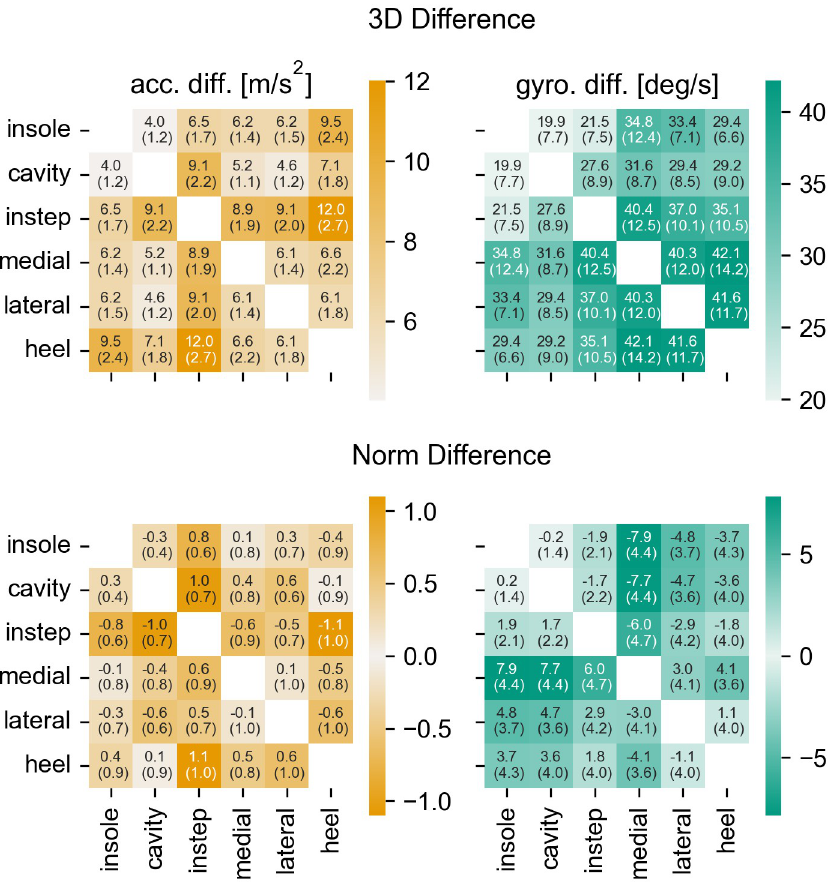
Fig 7. The raw data differences for all sensor axes. The 3D Difference (top) and the Norm Difference (bottom) over all strides for the accelerometer signal (left) and the gyroscope signal (right). The annotations provide the mean and the IQR over all strides. Note that the color for the Norm Difference is independent of the sign of the